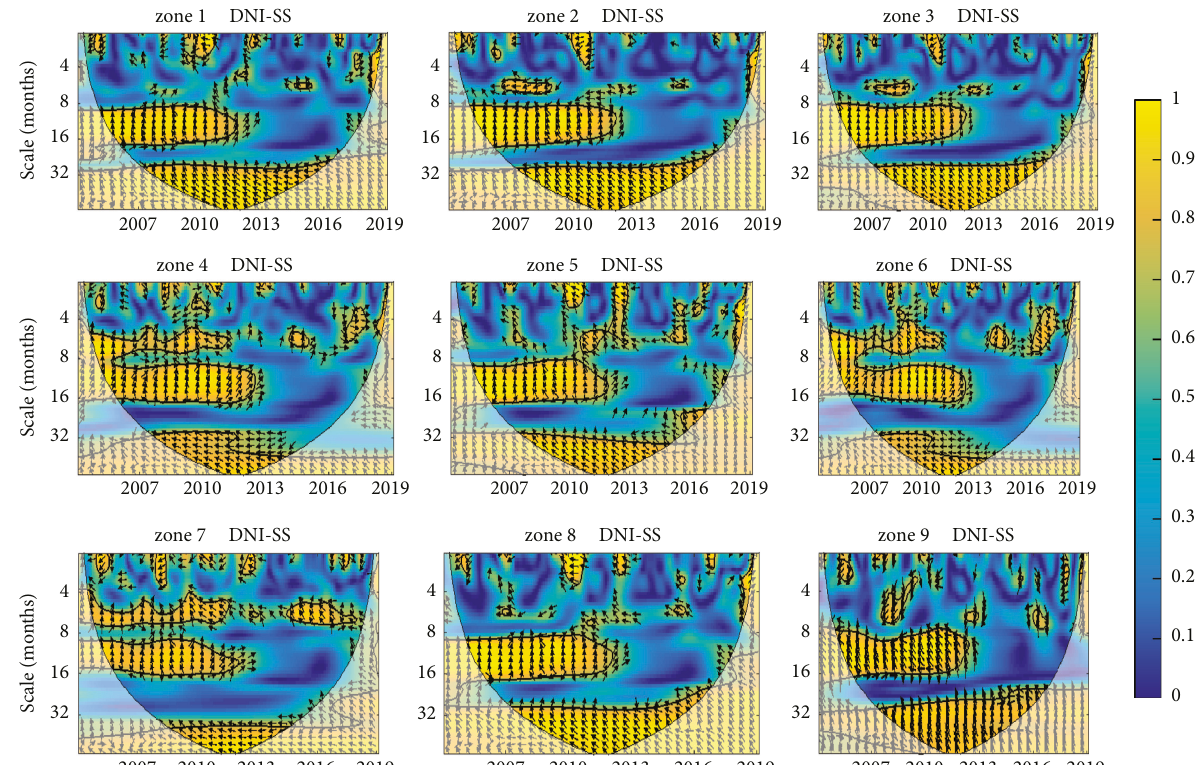
Figure 8: Wavelet coherence between the monthly average of DNI and SS time series (2005–2019). Areas of statistical significance are circled in black; the area outside the cone of influence has no statistical significance. The relative phase dependence is indicated by arrows (antiphase as oriented toward the left, and DNI in advance of phase to SS as arrows pointed